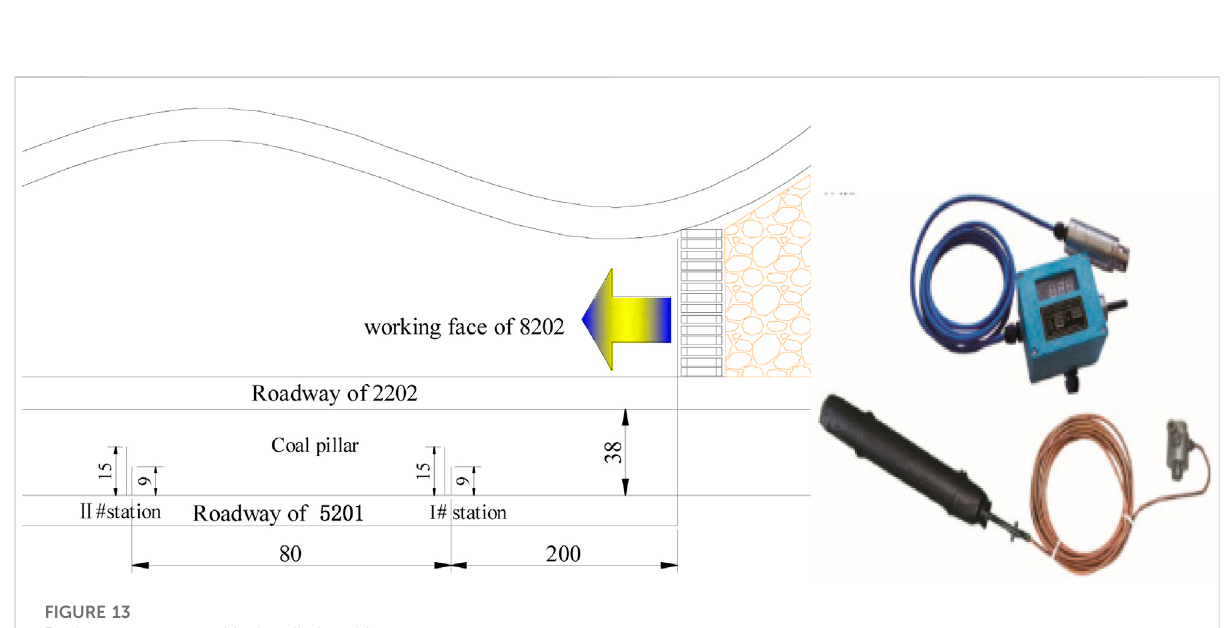
FIGURE 12 Dynamometer and its installed position.